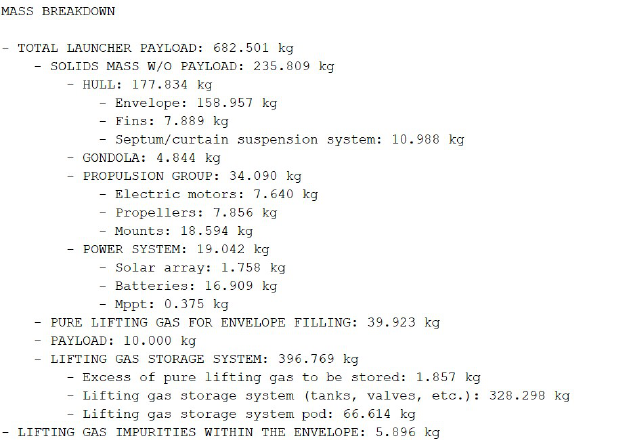
Figure 7. Mass breakdown of the HAPS optimal design for operation at 20 km altitude above Pontianak,